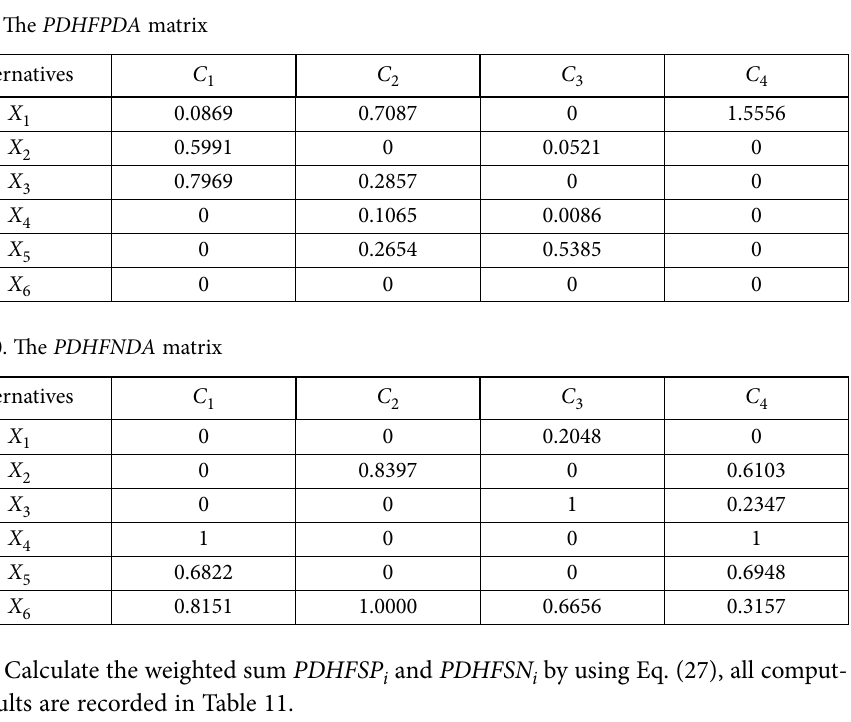
Table 11. The weighted sum PDHFSP i and PDHFSN i Alternatives X 1 PDHFSP i